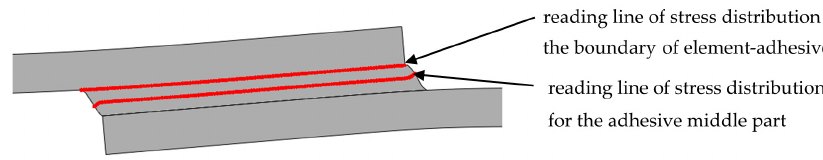
Figure 23. Localisation of the reading line of stress distribution on the boundary of element–adhesive and half length of the adhesive thickness.